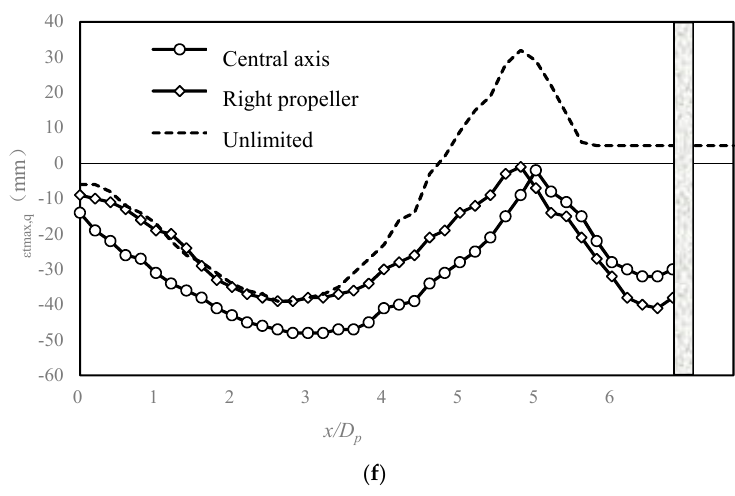
Figure 6. Values of axial scour depth for different propeller diameters and ( a ) ICRTP (3 D p ); ( b ) ECRTP (3 D p ); ( c ) ICRTP (5 D p ); ( d ) ECRTP (5 D p ); ( e ) ICRTP (7 D p ); ( f ) ECRTP (7 D p ).